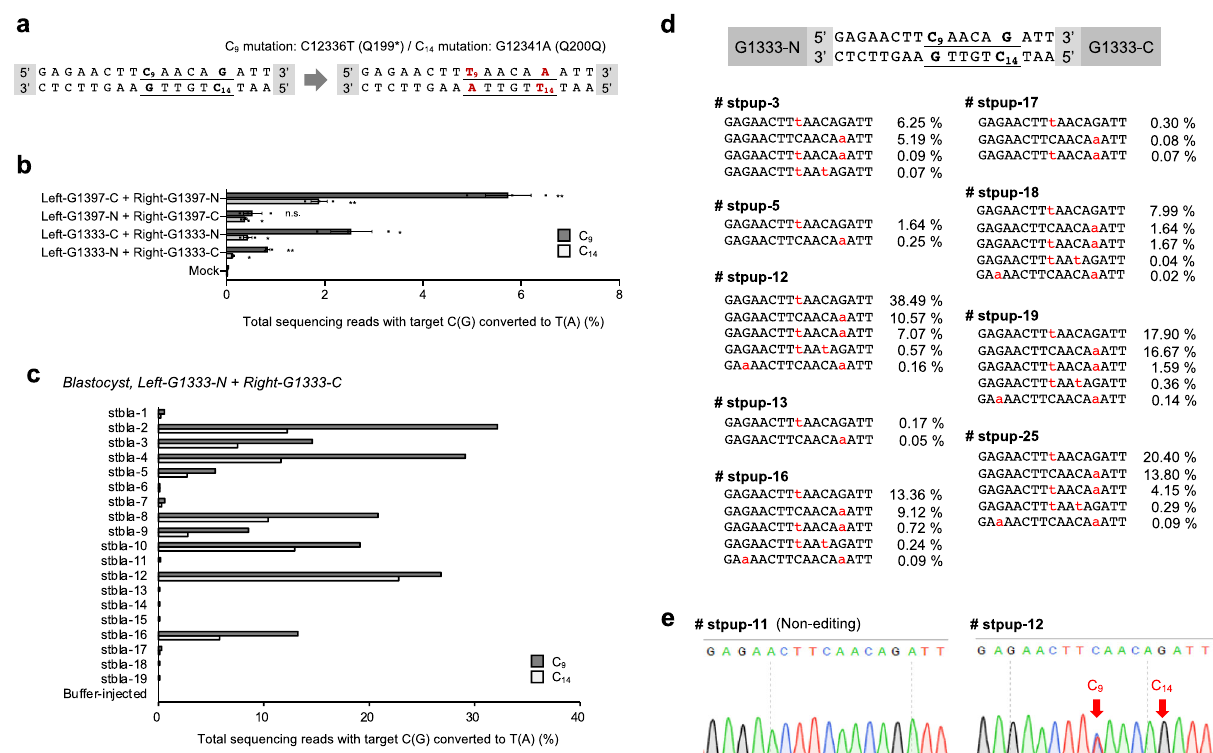
Fig. 5 Mouse mitochondrial ND5 nonsense mutation generated via cytidine-deaminase-mediated base editing. a The DdCBE target for generating the m. C12336T nonsense mutation and m.G12341A silent mutation. The m.C12336T (C 9 ) mutation creates a Q199stop mutation in the ND5 protein, whereas m. G12341A (C 14 ) causes a silent Q200Q mutation. Translation triplets are underlined and possible editing loci are shown in red. b The ef fi ciency of the cytosine-to-thymine base editing that creates a nonsense mutation in NIH3T3 cells. The annotations indicate the combination of DdCBE pairs that were co- transfected into cells. Dark and light gray bars represent the frequency of m.C12336T (C 9 ) and m.G12341A (C 14 ) mutations, respectively. Error bars represent s.e.m. for n = 3 biologically independent samples (n.s. not signi fi cant, * p < 0.05, and ** p < 0.01 using Student ’ s two-tailed t test). P values of left- G1333-N + right-G1333-C, left-G1333-C + right-G1333-N, left-G1397-N + right-G1397-C, and left-G1397-C + right-G1397-N for C 9 mutation are 0.0065, 0.1143, 0.0266, and 0.0037, and for C 14 mutation are 0.0077, 0.0144, 0.0406, and 0.0214, respectively. c Base editing ef fi ciency in mouse blastocysts. The sequencing data were obtained from blastocysts that developed after zygotes were microinjected with mRNA encoding left-G1333-N and right-G1333-C DdCBE. Dark and light gray bars represent the frequency of the C 9 and C 14 mutations, respectively. d Alignment of mutant sequences from newborn pups. Edited bases are shown in red, and the column on the right indicates the editing frequencies in the mutant mitochondrial genome. e Sanger sequencing chromatograms from non-edited and edited mice. The red arrows indicates the substituted nucleotides. Source data are provided in the Source data fi